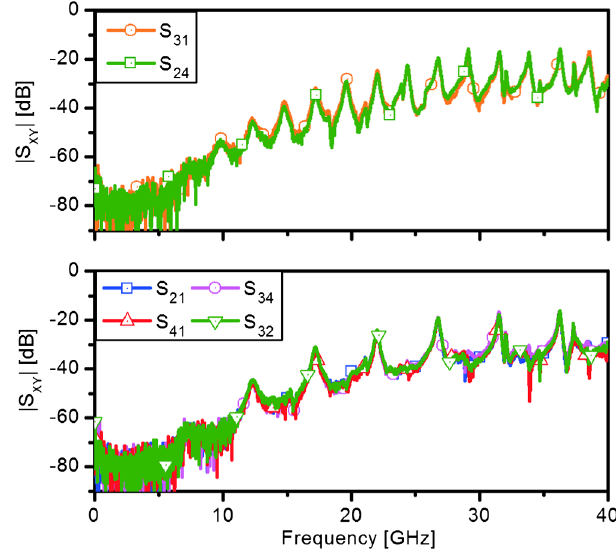
FIG. 7. Measured transmission coefficient between the ports. Top: Between neighboring ports. Bottom: Between opposite ports.